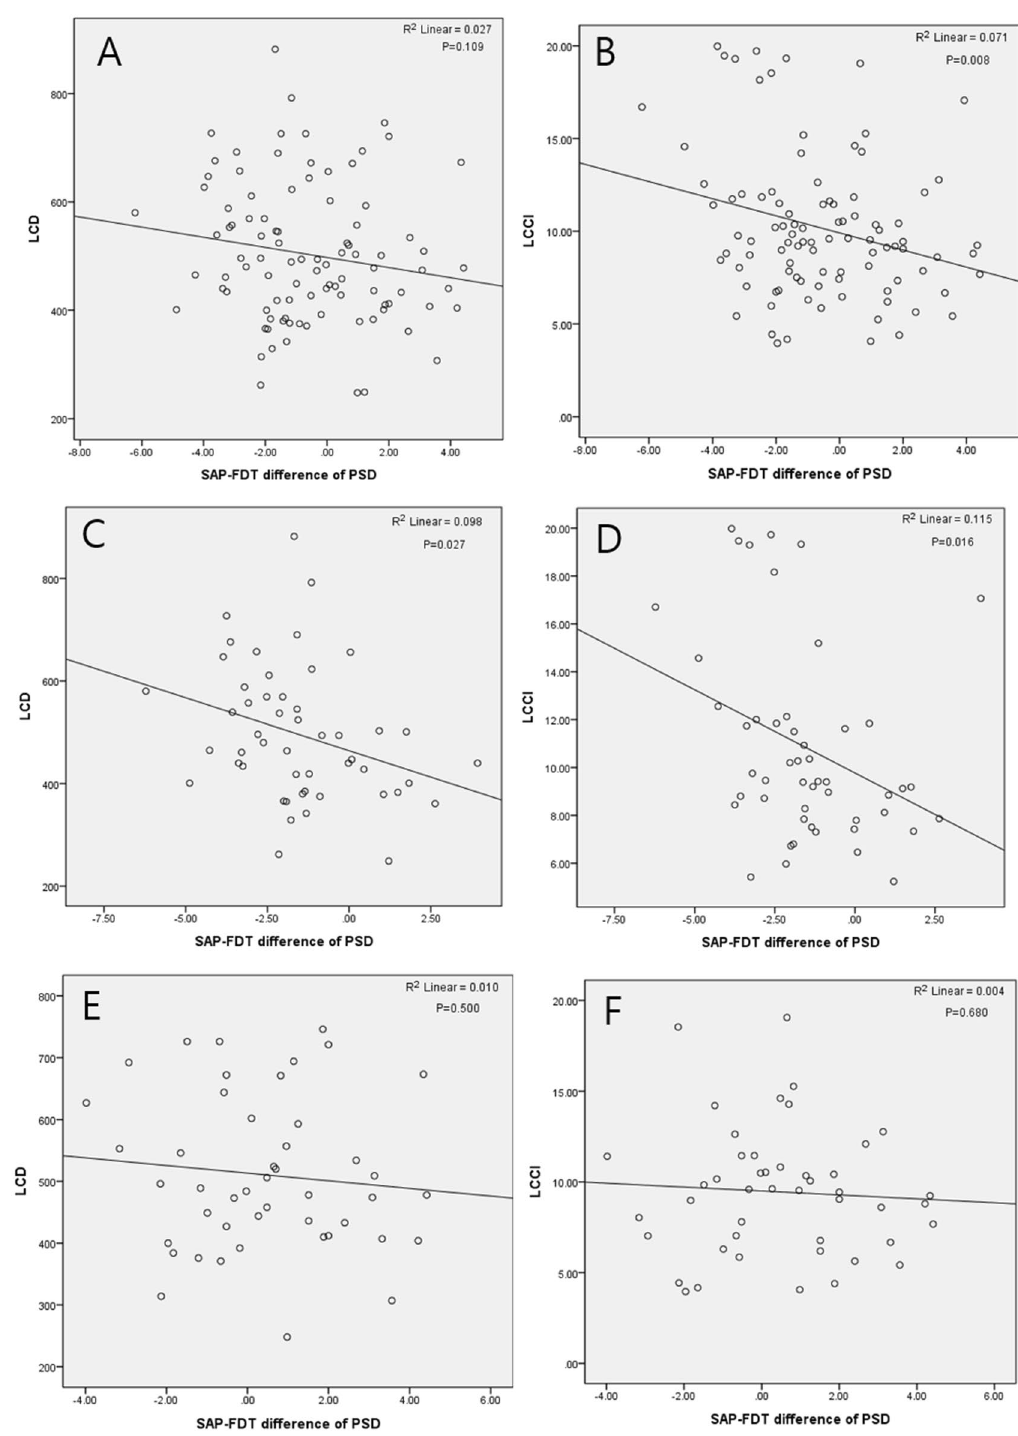
Figure 2. Scatterplot between SAP–FDT difference of pattern standard deviation (PSD) and posterior deformation of lamina cribrosa. In whole group, SAP–FDT difference of PSD and lamina cribrosa depth (LCD) or lamina cribrosa curvature index (LCCI) showed negative correlation ( A,B ). As the SAP–FDT difference of PSD gets greater, there was increase in LCD and LCCI with statistical significance in peripheral nasal step group ( C,D ). This trend was not observed in parafoveal scotoma group ( E,F ). Linear regression analysis was